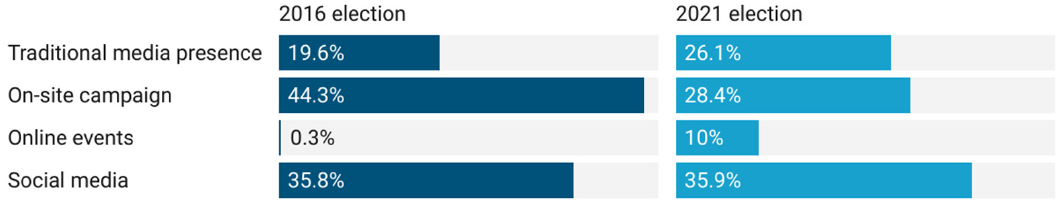
Figure 1. Traditional vs. Digital Campaigning. Comparison between the 2016 and 2021 presidential election campaigns. Source: Own data (see Section 3.1.1).